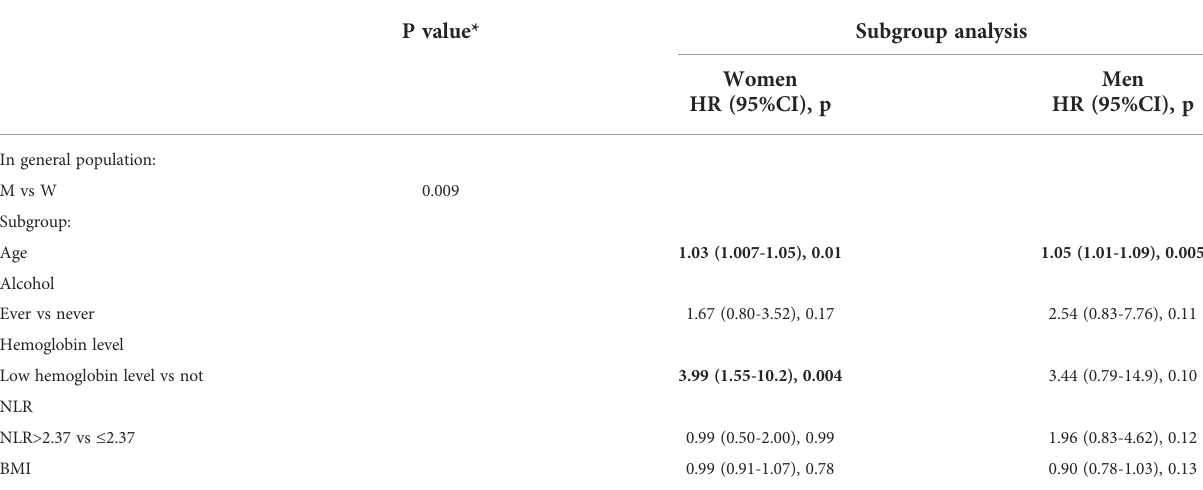
TABLE 4 Overall Survival (OS) for stage I-II patients, multivariate analysis.